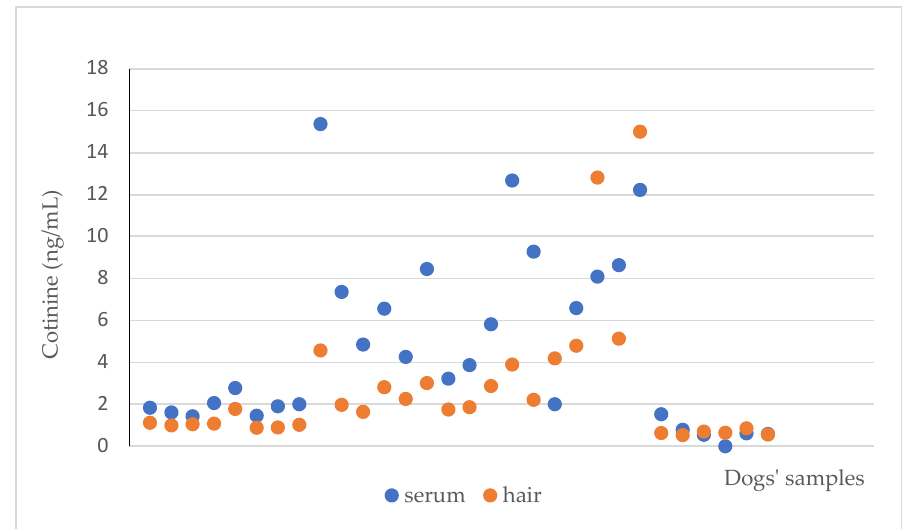
Figure 1. Serum and hair cotinine concentrations in the total caseload. Serum cotinine significantly differed between the EX and UE group ( p < 0.001), with higher serum values in dogs living with smoking owners (7.4 ± 3.7 ng/mL) than in unexposed ones (1.5 ± 0.7 ng/mL; Figure 2).